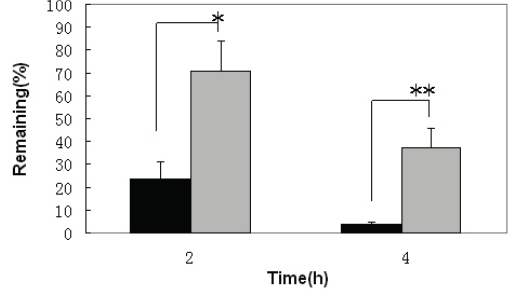
Figure 3. The examination of gastric bioadhesive property. The remaining percentage of pexiganan on the gastric mucosa of rats 2 h (* p < 0.05) and 4 h (** p < 0.01) after oral administration of pexiganan suspension (black bars) and pexiganan nanoparticles (PNPs) (gray bars) ( n =